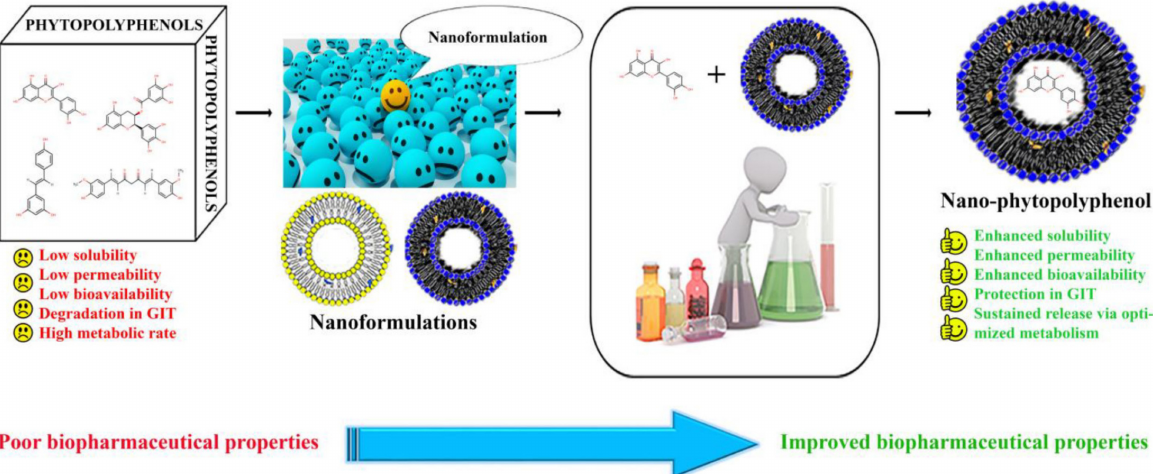
Figure 3. Schematic representation of biopharmaceutical improvements of dietary polyphenols for